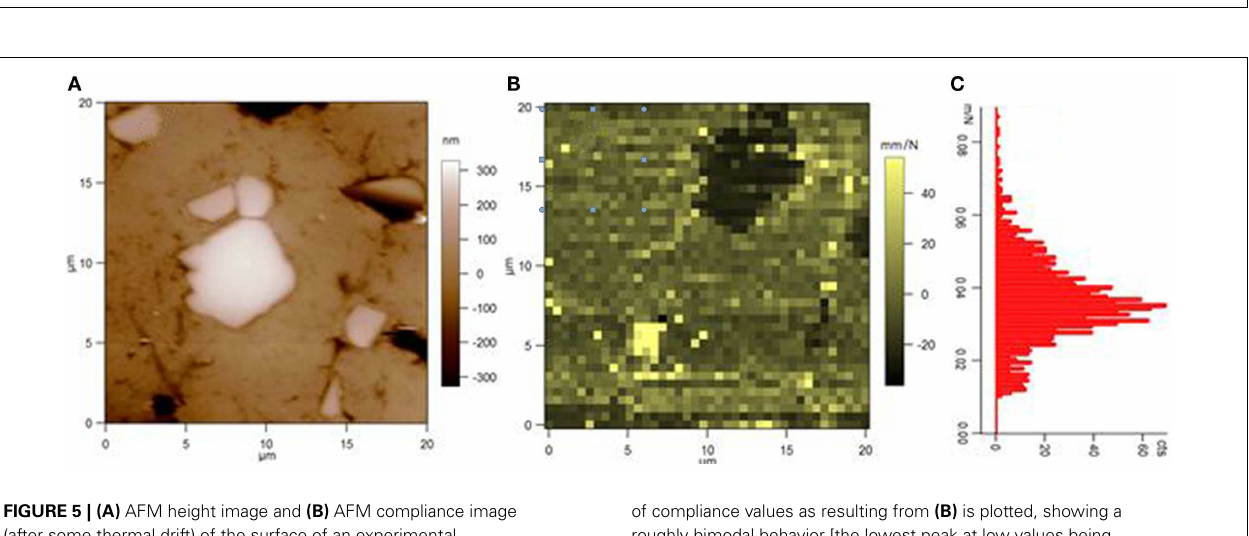
FIGURE 4 | (A,B) Typical response of DMA at 1Hz (similar to mastication frequency), showing the values at the different temperatures scanned in the “oral” range of icy drinks to hot soups of both (A) the elastic part of the complex modulus of the specimen material and (B) the viscous part (loss